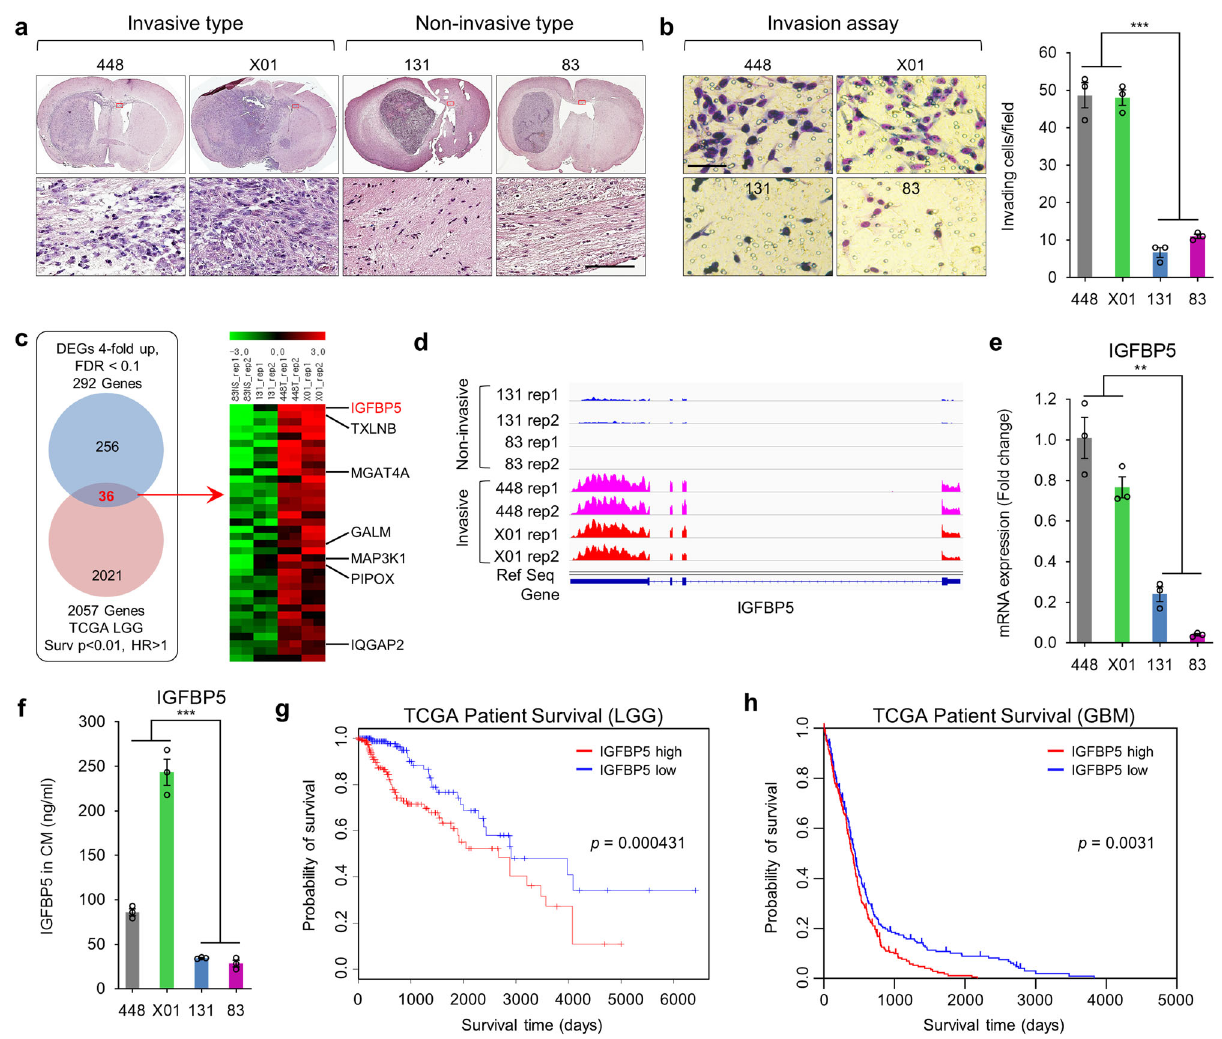
Fig.1|IGFBP5expressionisassociatedwithGSCsinvasionandpatientsurvival in glioma. a Hematoxylin and eosin (H&E) staining of the whole brain from mice implantedwithGSCs(448,X01,131,and83).Scalebar,100 μ m. b Invasionassaysof